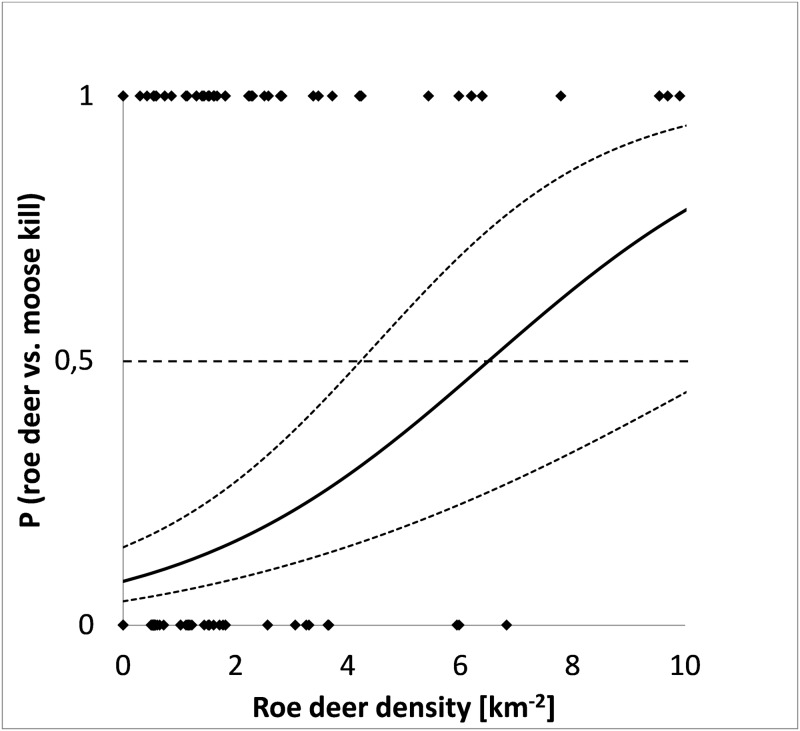
The probability of killing roe deer or moose (± SE) by wolves in Scandinavia as related to local (intra-territorial) variation in roe deer density at kill sites (n = 365) at mean moose density (1.8 / km2).The stippled line (Y = 0.5) indicates equal probability for wolves to kill roe deer or moose. Dots represent either moose kills (Y = 0) or roe deer kills (Y = 1).